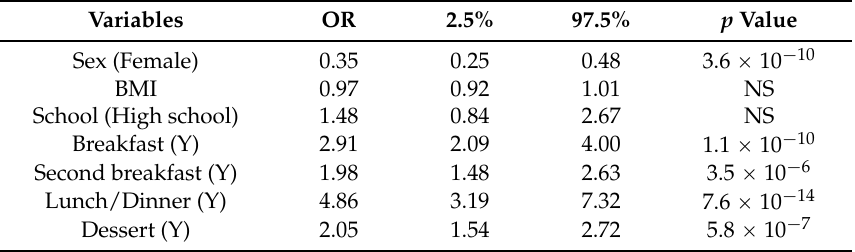
Table 5. Adjusted odds ratios for supper consumption with regard to sex, BMI, age (expressed as level of education) and other meals